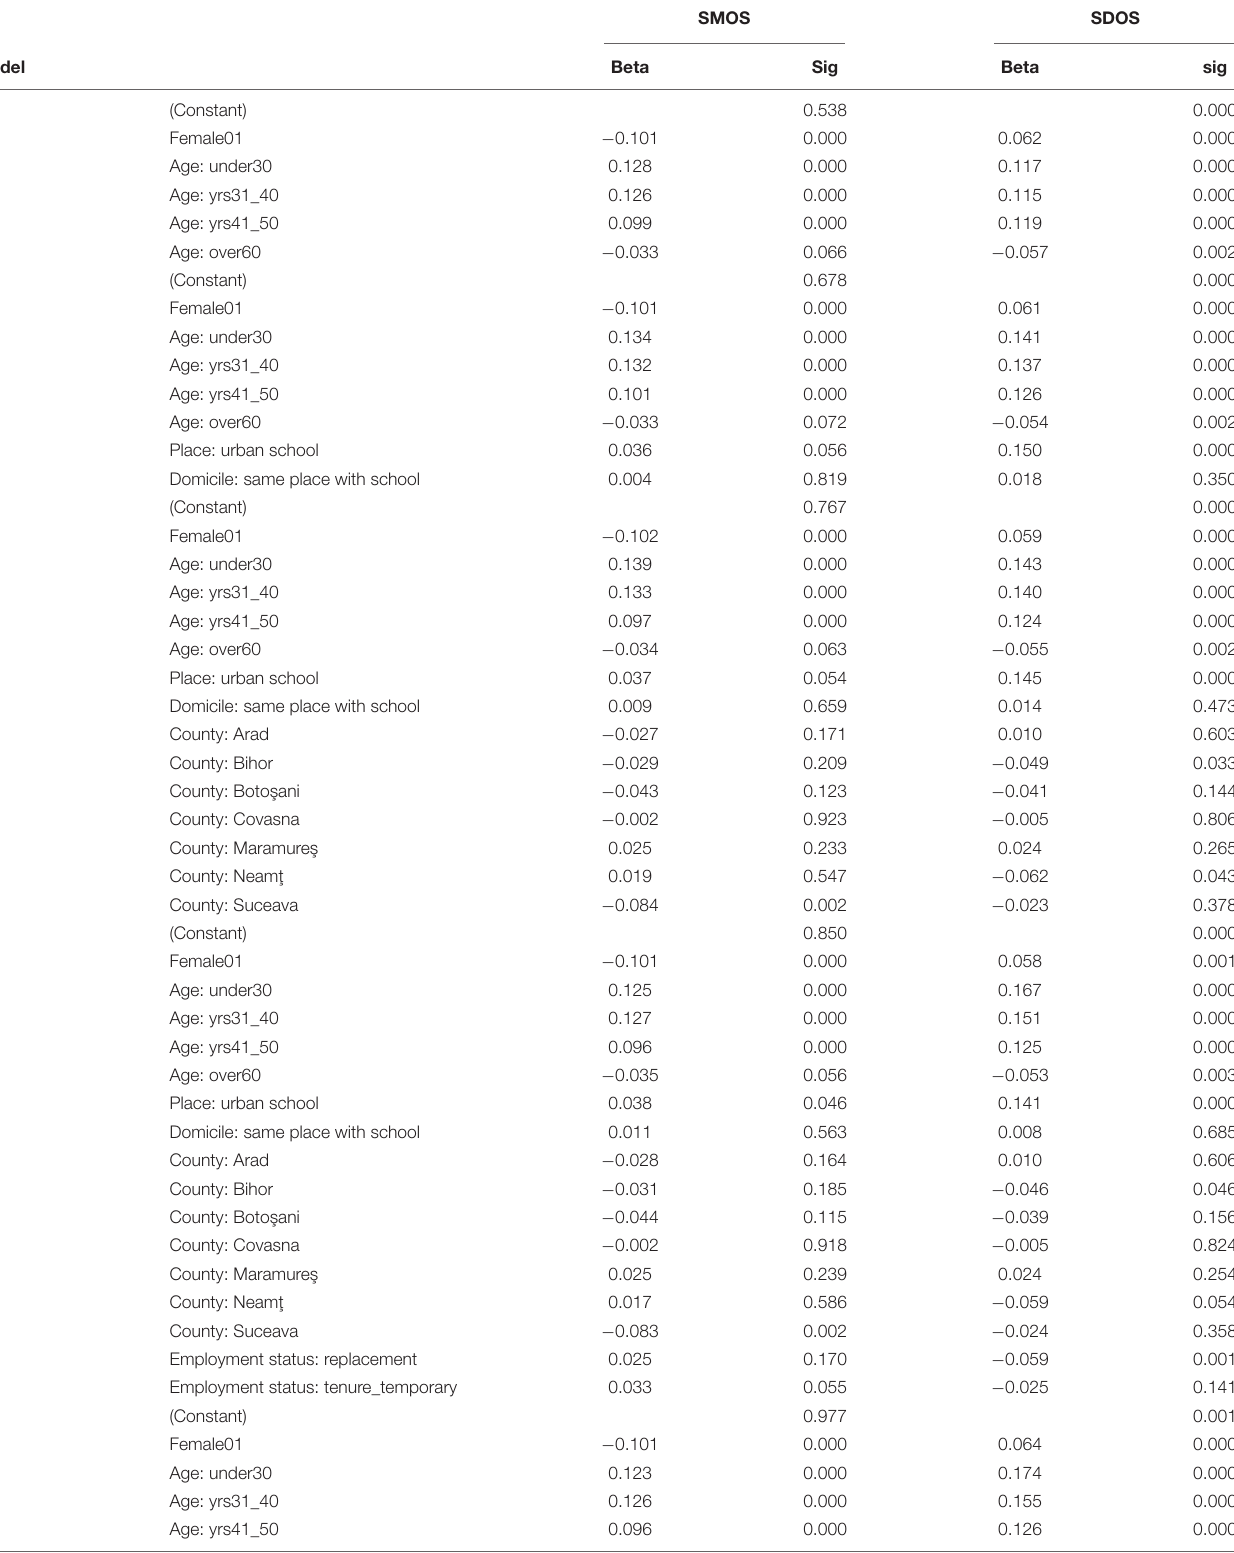
TABLE 4 | The models